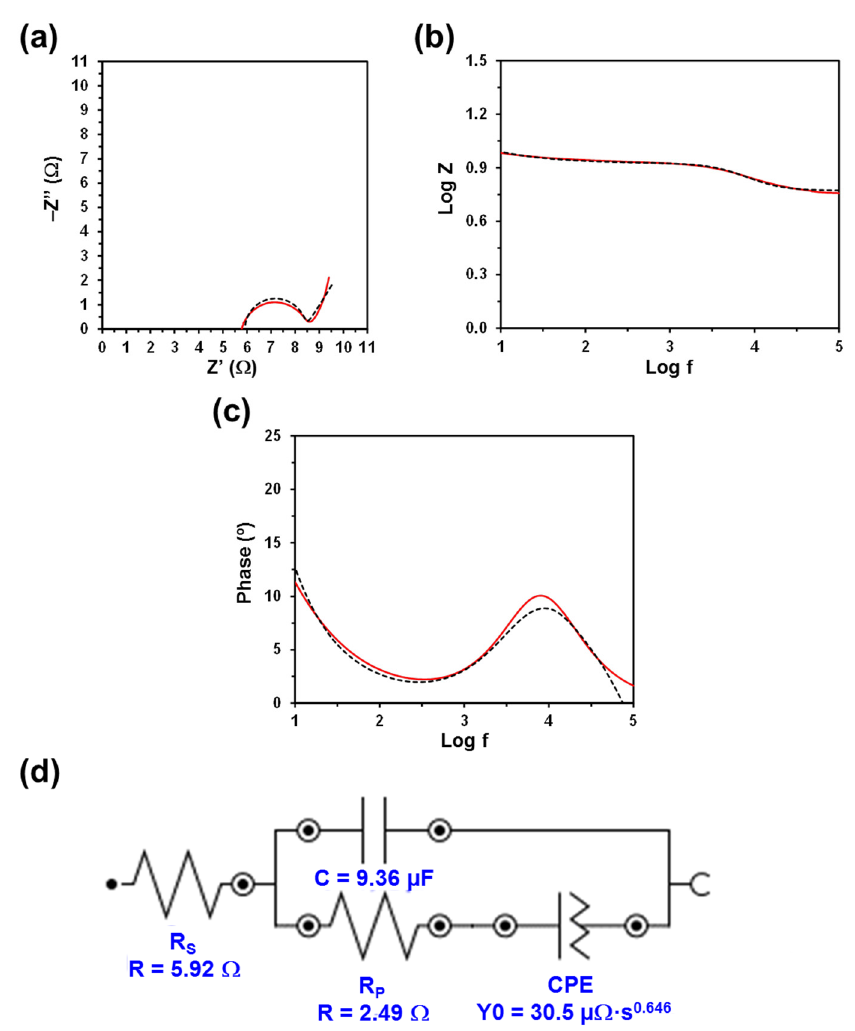
Figure 5. Measured and fitted EIS spectra (solid red line and dashed black line, respectively) for the PGGA hydrogel sandwiched between two PEDOT electrodes: ( a ) Nyquist plot; ( b ) impedance Bode plot; and ( c ) phase Bode plot. ( d ) EEC model used for numerical fitting of the EIS data. Numerical results from fitting the spectra are displayed for all the elements of the EEC.